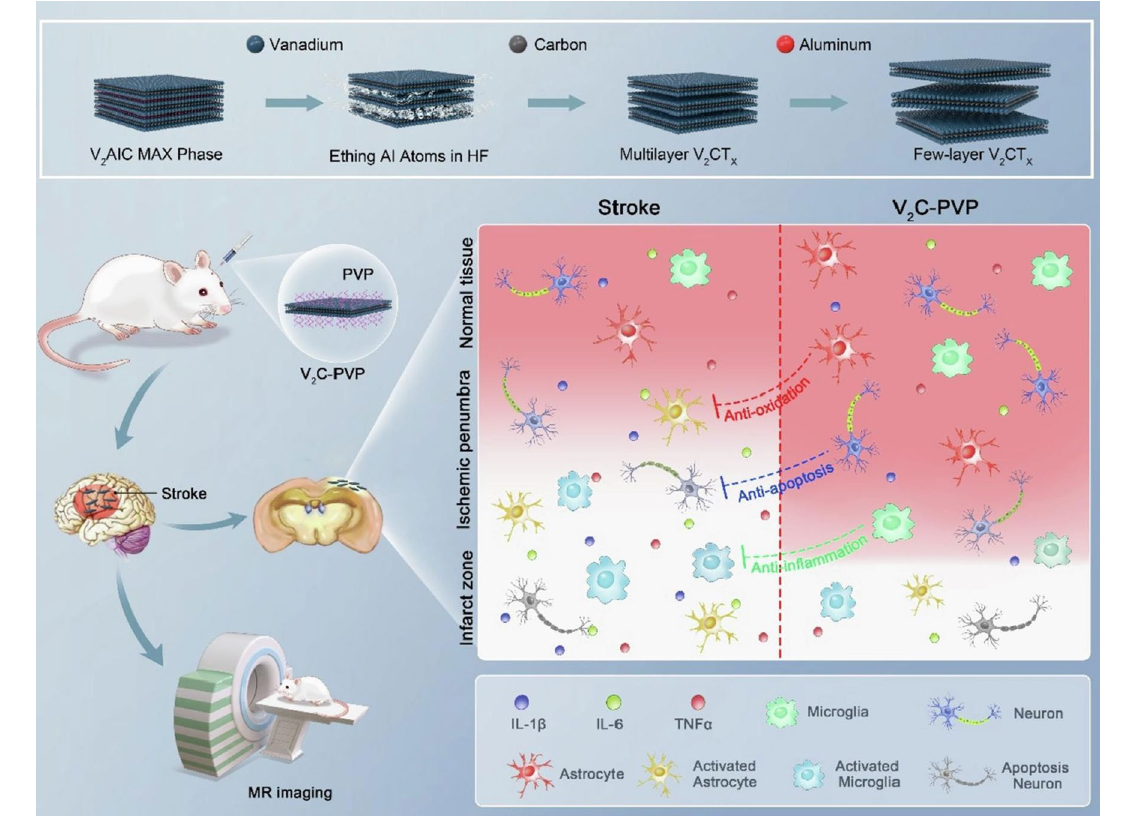
Fig. 6 MXene (V 2 C)-based nanozymes with intrinsic multiple enzyme-like performances as theranostic nanoplatforms for treating ischemic stroke through the alleviation of oxidative stress, suppression of cell apoptosis and reduction of inflammation. HF hydrogen fluoride, PVP poly- vinylpyrrolidone; MR magnetic resonance. Reproduced with permission from Ref. [72]. Copyright 2022